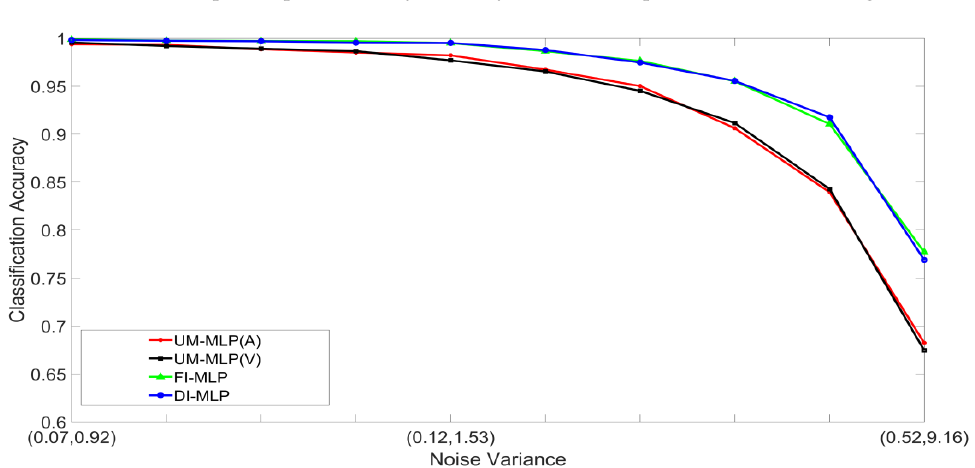
Figure 7. Classification accuracy, as a function of noise, for the MLP-based classification systems.